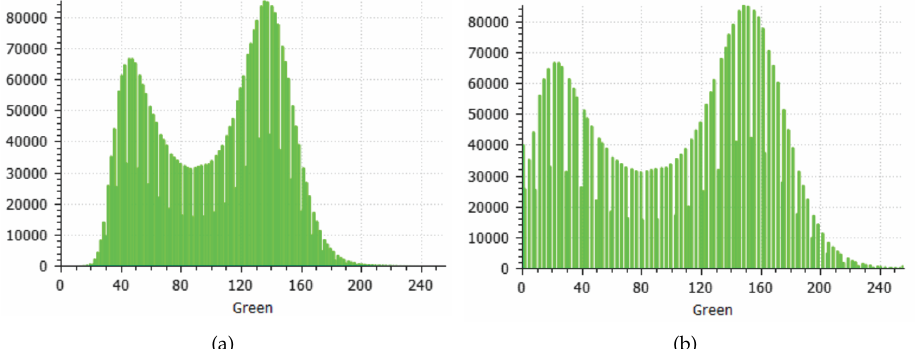
Figure 13. Green Channel Color Normalization. ( a ) Before. ( b ) After.